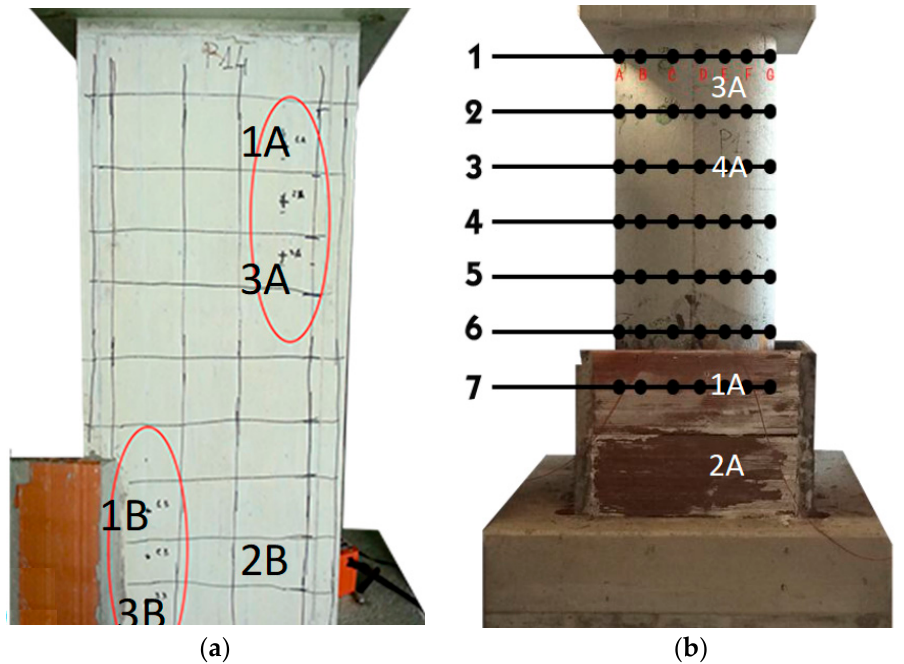
Figure 4. Measurements’ points for SonReb method and corrosion potential: ( a ) rectangular and ( b ) circular hollow pier.